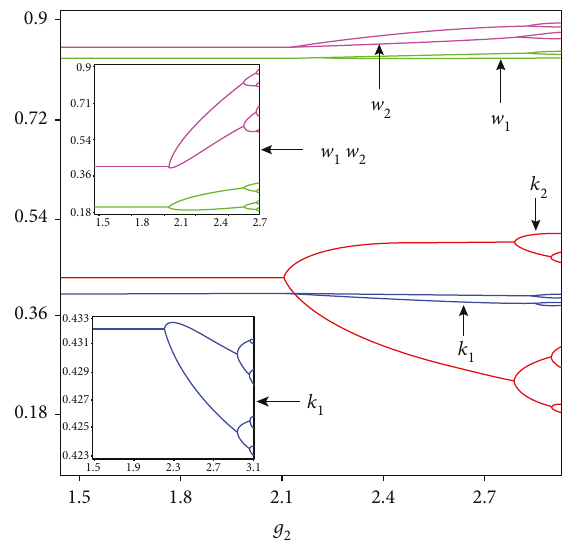
Figure 7: Bifurcation diagram of k